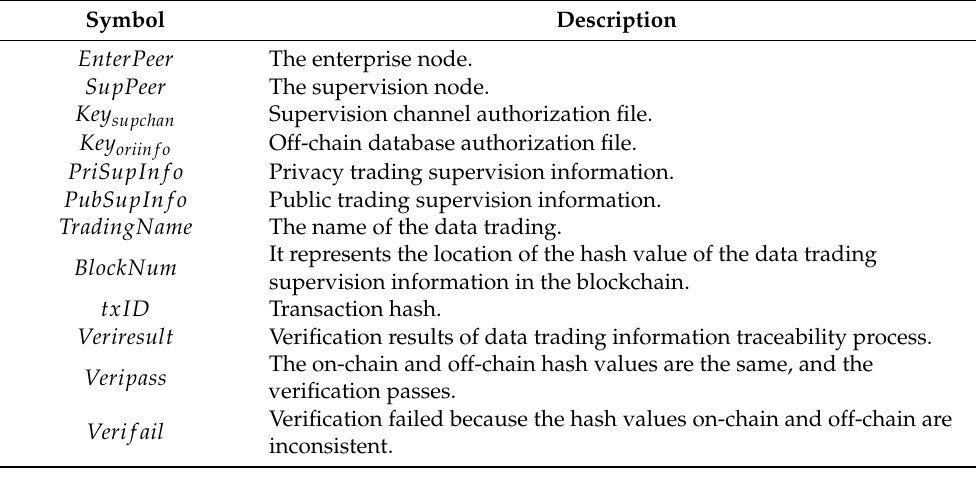
Algorithm 2: Smart contract for public supervision information on-chain